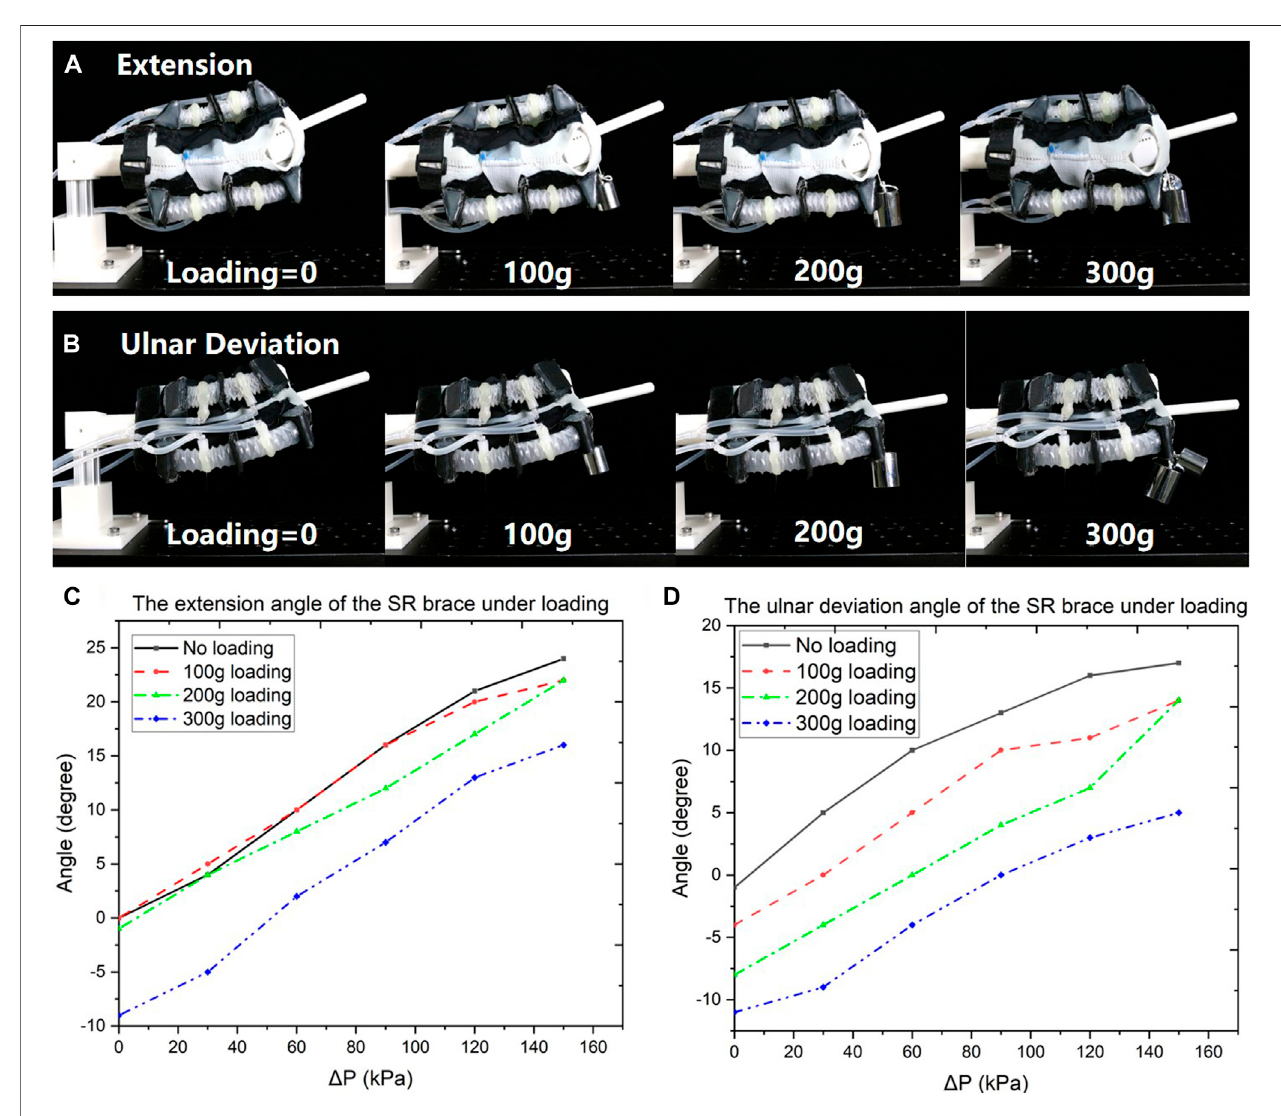
FIGURE8| Theperformanceof theSR brace under loading wasmeasured. The weights 100, 200, and 300 gwereattached tothe distal end ofthe SRbrace; the output angles were measured in (A) extension and (B) ulnar deviation.